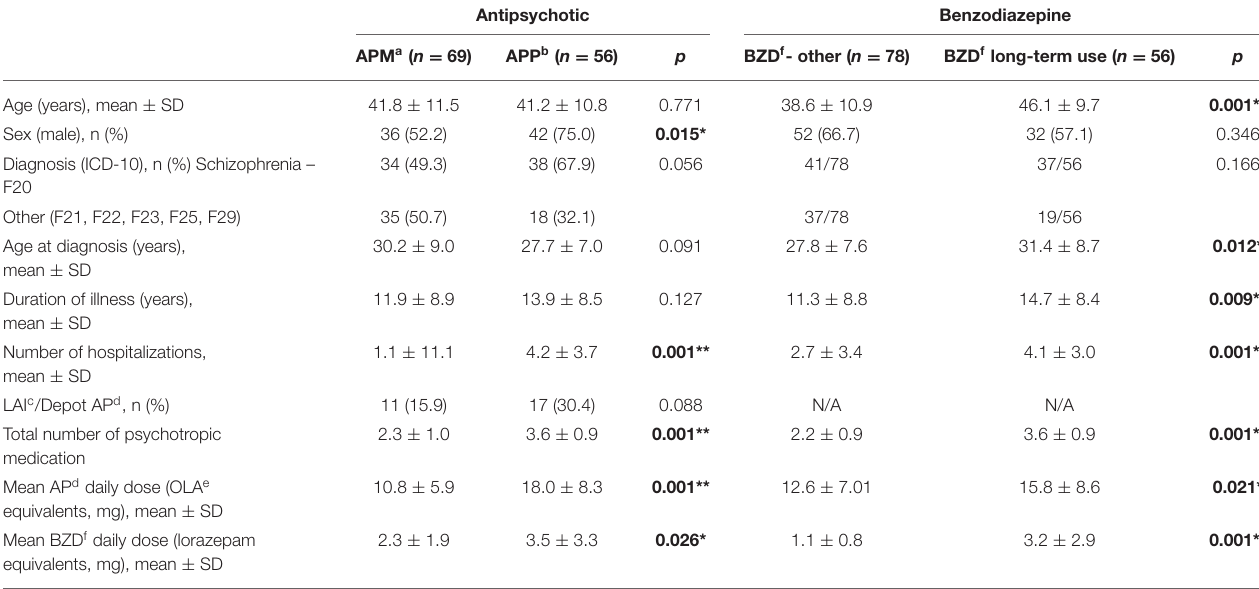
TABLE 3 | Antipsychotic and benzodiazepine prescription patterns and their relation to sociodemographic and clinical parameters.